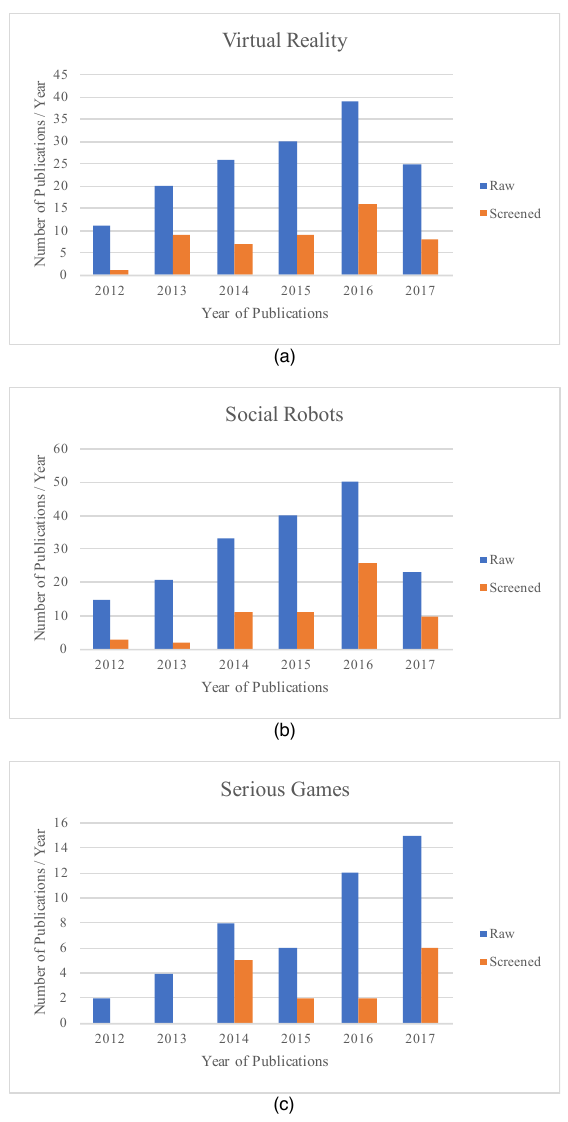
Figure 2. Web of Science search results. ( a ) The raw and screened number of publications per year using the search term “virtual reality autism”; ( b ) The raw and screened number of publications per year using the search term “social robots autism”; ( c ) The raw and screened number of publications per year using the search term “serious games